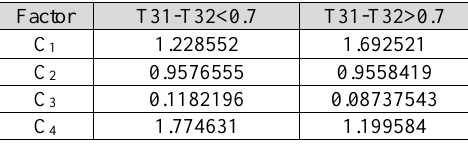
Table 4. Coefficients for the MODIS Band 31 and 32 SST retrieval algorithm, derived using ECMWF assimilation model marine atmospheres to define atmospheric properties